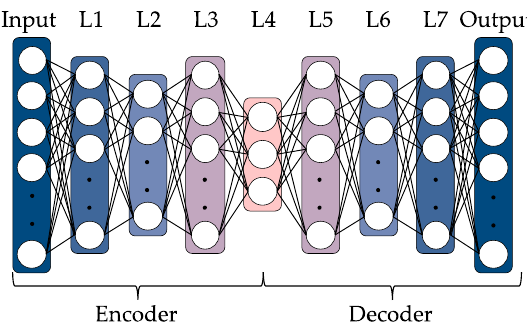
Figure 4. Diagram of the developed deep autoencoder. L1–L7 are the intermediate layers and L4 is the feature extraction layer. The numbers of neurons are the same for L1 and L7, L2 and L6, and L3 and L5. The dimension of features, which is the number of neurons in L4, is three and the numbers of neurons in L1, L2, L3, L5, L6, and L7 are optimized in the range of 5 to 999 by Optuna.